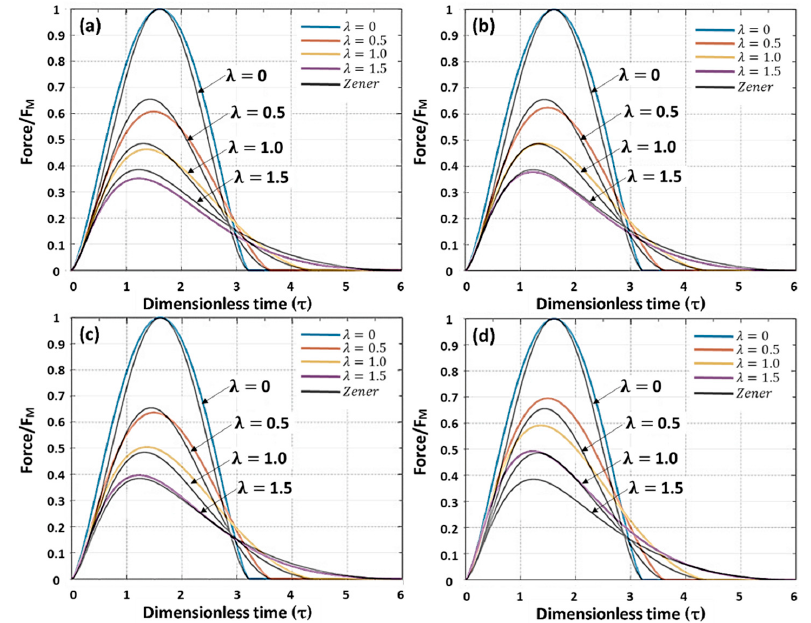
Figure 8. Equation (33) multiplied by ( 1 + n × λ ) 2 , when ( a ) n = 0.15, ( b ) n = 0.18, ( c ) n = 0.2, and ( d ) n = 0.3.